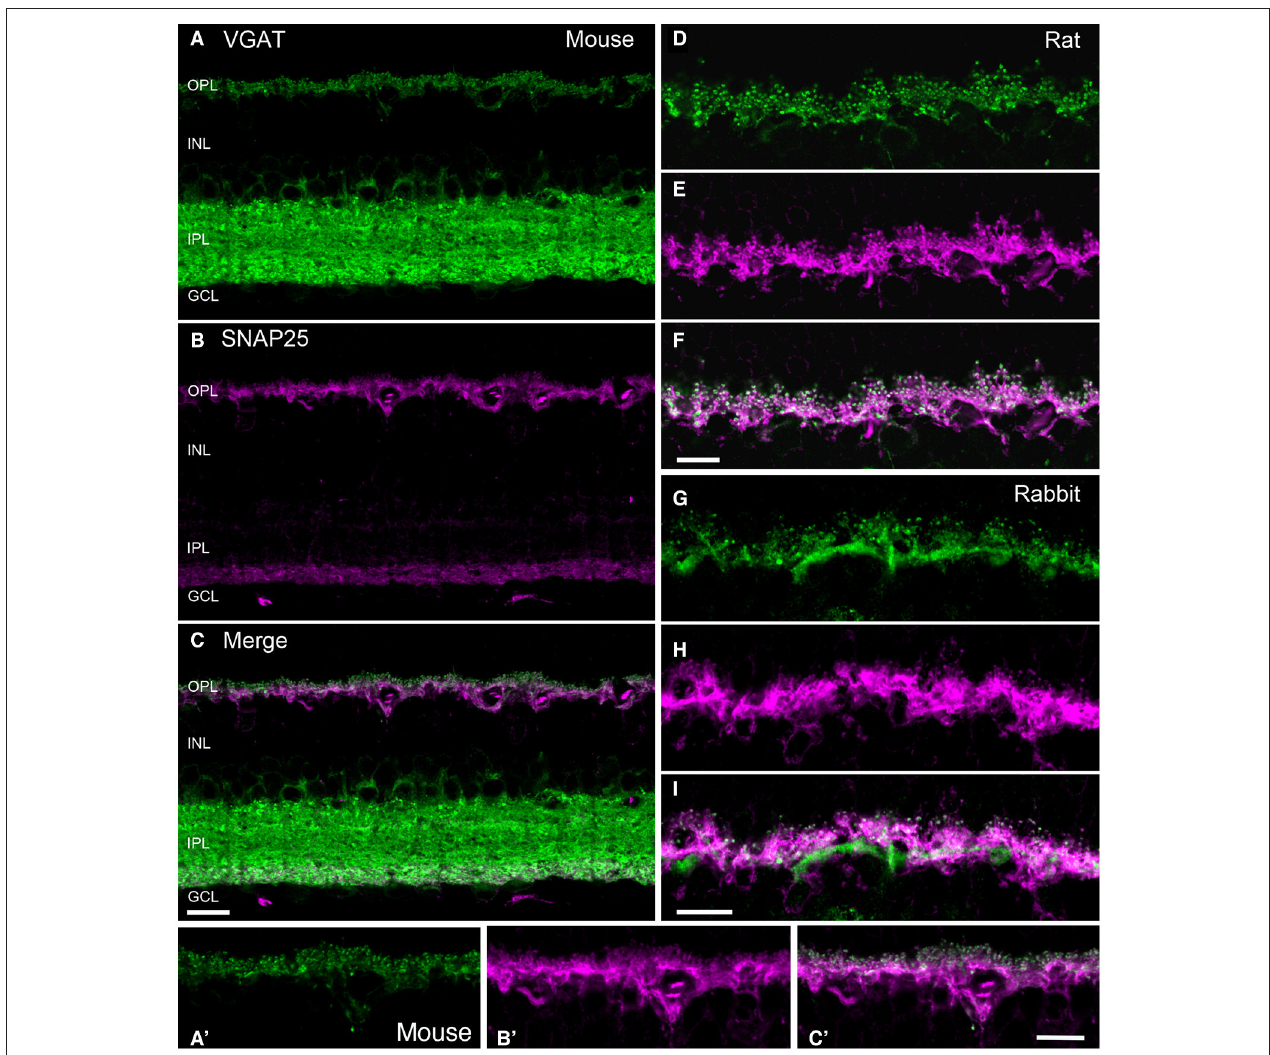
FIGURE 5 | SNARE protein SNAP-25 co-localized with VGAT in horizontal cell processes in mammalian retina. VGAT antibody staining (green) of a vertical section of mouse (A,A’) , rat (D) , and rabbit (G) retinas showed immunolabeling in the OPL and the IPL, and around cell bodies of the proximal inner nuclear layer (INL). SNAP-25 antibody labeling (magenta) of the same section produced immunolabeling in the OPL and the proximal IPL of mouse (B) , and OPL of mouse (A’) , rat (E) , and rabbit (H) retinae. Merged images of the VGAT and SNAP-25 immunolabeling (white) indicated co-localization of SNAP-25 with VGAT in the tips of horizontal cells in mouse (C,C’) , rat (F) , and rabbit (I) . GCL, ganglion cell layer. Maximum intensity projections. Scale bar, 10 µ m in (C) (applies to A–C ), (F) (applies to D–F) , and (I) (applies to G–I ). (Modified from Hirano et al.,